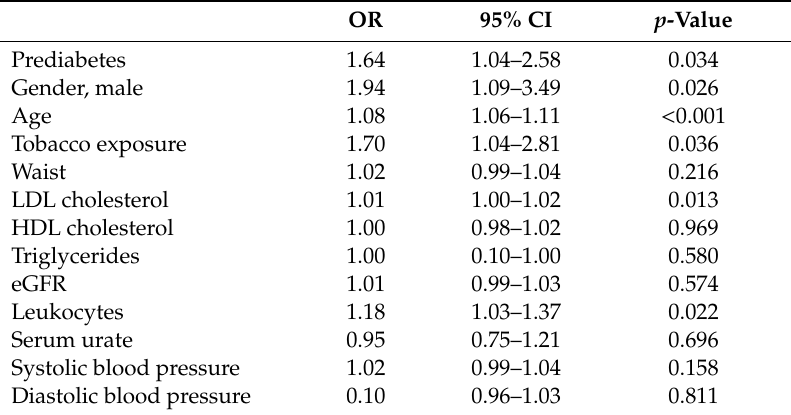
Table 4. Logistic regression analysis for the predictors of carotid